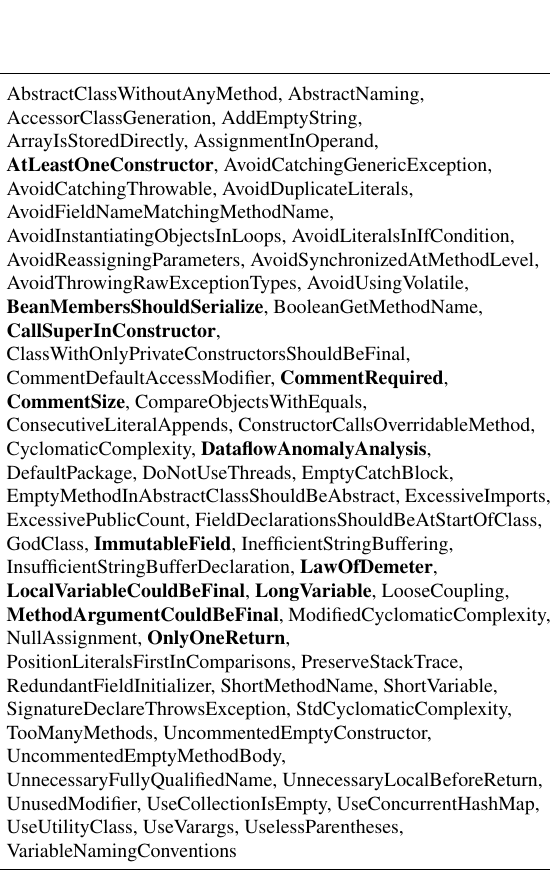
Fig. 4. Commonly-disregarded violations in all